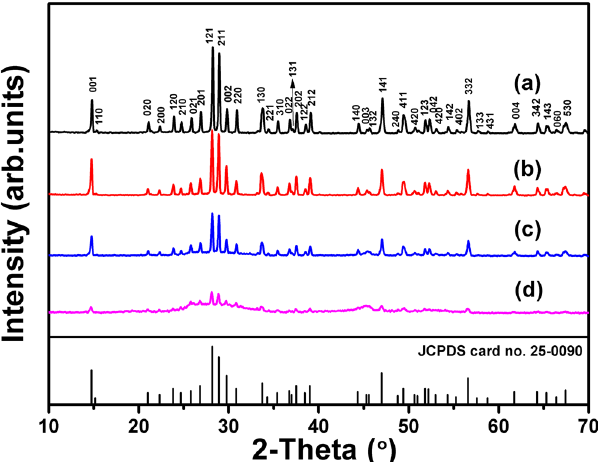
Figure 1. XRD patterns of the obtained Bi 2 Fe 4 O 9 samples with different etching times: ( a ) 0; ( b ) 15 min; ( c ) 30 min; ( d ) 45